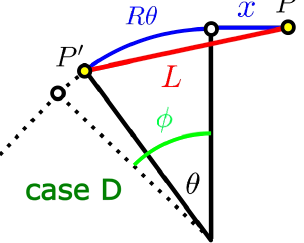
7. Geometry for case D. Note that the θ here is not the θ defined in either case A or